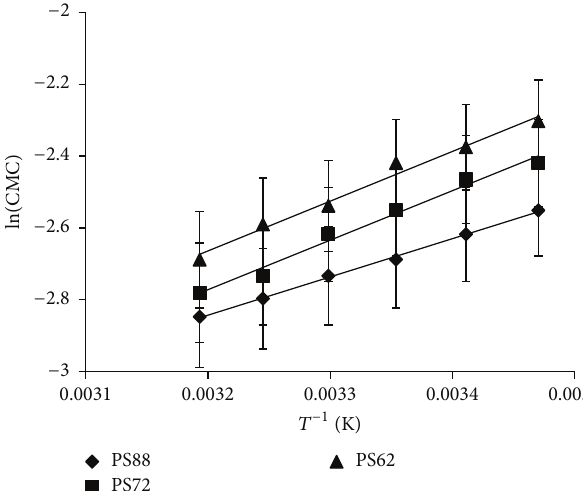
Figure 6: Log of CMC as a function of reciprocal of temperature (in Kelvin) at which the CMC was measured.